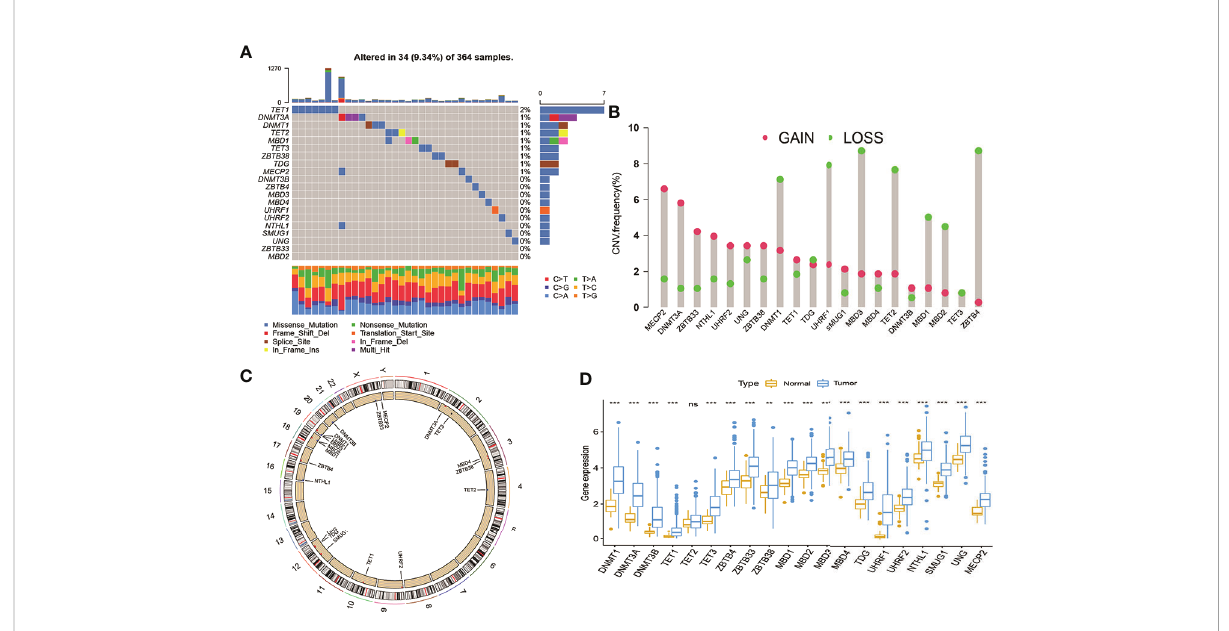
FIGURE 1 Landscape of genetic variations and transcriptional expression of DNA methylation regulators in HCC from TCGA cohort. (A) 34 of the 364 patients occurred genetic variations of 20 DNA methylation regulators with 9.34% mutation frequencies. (B) The frequency of CNV gain or loss among DNA methylation regulators. (C) The locations of CNV variations in DMRs on 23 chromosomes. (D) The expression level of 20 DNA methylation regulators between normal and HCC tissues. HCC, hepatocellular carcinoma; TCGA, The Cancer Genome Atlas; CNV, copy number